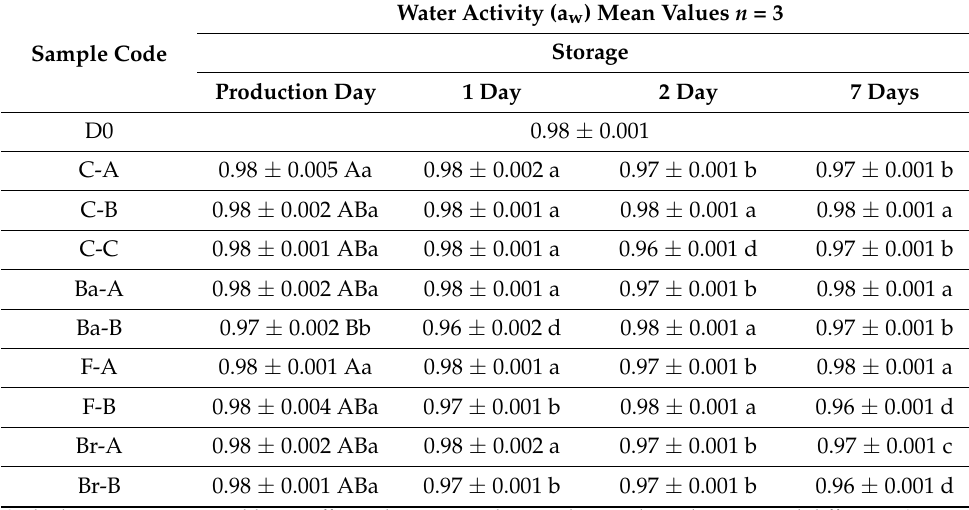
Table 5. Water activity of culinary chicken breast samples.